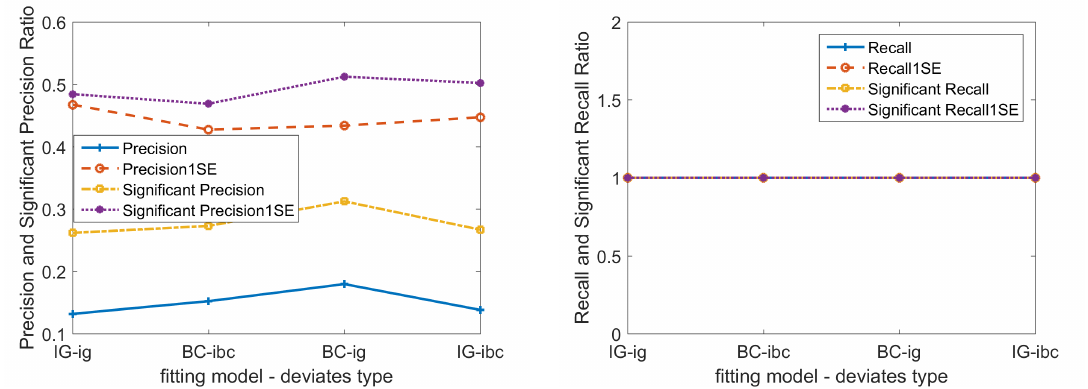
Figure 3. Base case scenario: performance evaluation for simple fitting models. 1. ( Top-left panel ) is precision; ( Top-right panel ) is recall; ( bottom-left panel ) is MAE and RMSE; and ( bottom-right panel ) is deviance. 2. We draw fitting results of minimum deviance λ minimum − deviance and of 1 standard error deviance λ 1 SE , respectively. 3. In simple fitting models, we use univariate λ BC for Box–Cox transformed Gaussian LASSO model and canonical link function g ( µ ) = µ − 2 for IG GLM LASSO